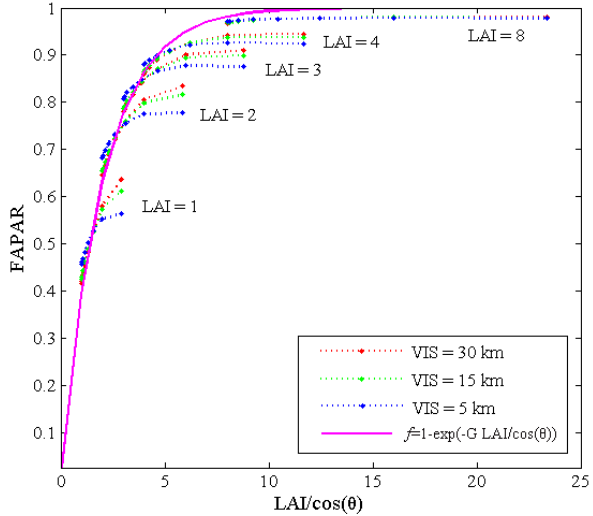
Figure 5. Relationship of FAPAR and LAI/cos( θ ) derived from the FAPAR model integrating FAPAR- P and 6S model.